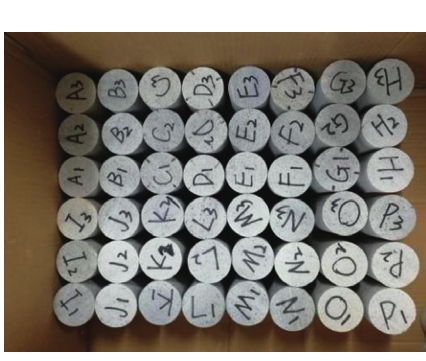
Figure 5: Test sandstone